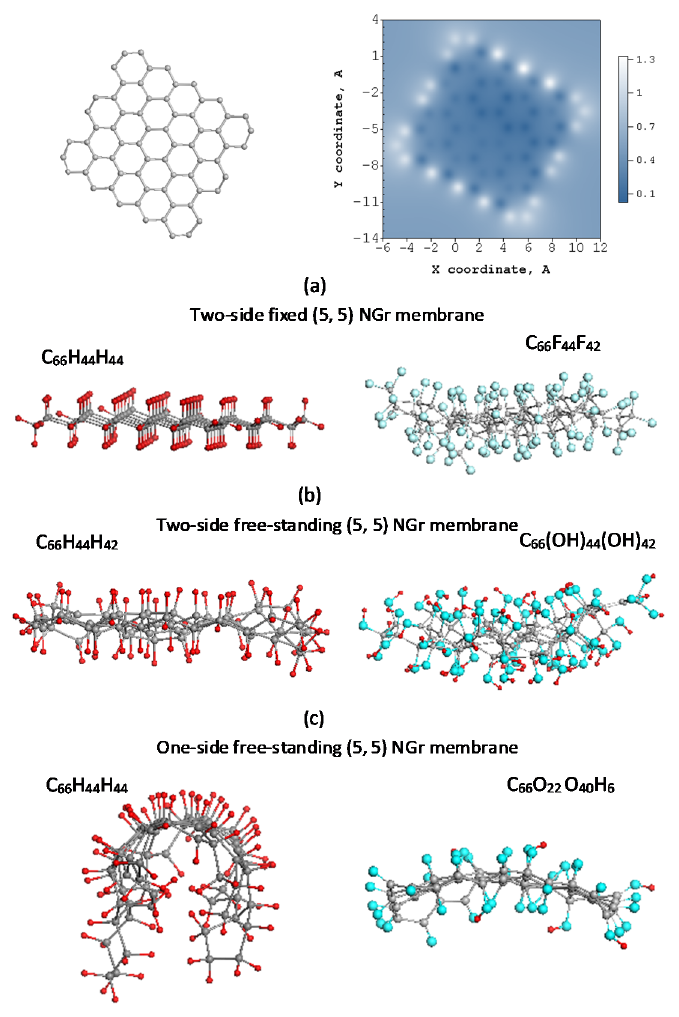
Figure 8. Top–Equilibrium structure of the (5, 5) NGr molecule and the spatial map of the ACS N DA distribution over its atoms. ( a – c ) Equilibrium structures of complete graphene hydrides (left column), graphene fluoride, and two graphene oxides (right column, from top to bottom). The double notification, say, C 66 H 44 H 44 , means that the first 44 hydrogen atoms are bound with 22 edge atoms of the (5, 5) NGr molecule, while the other 44 hydrogens are attached to the carbon atoms located in the molecule basal plane.